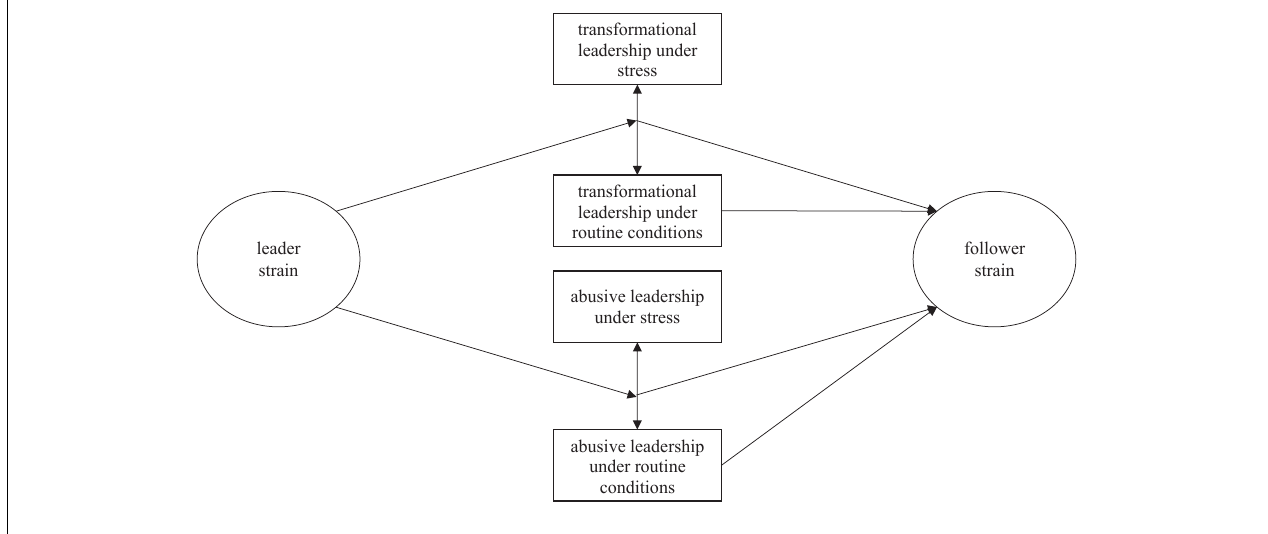
FIGURE 1 | Conceptual model of the